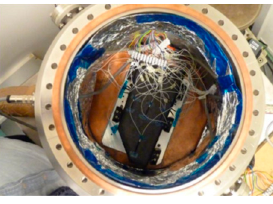
Figure 23. Breadboard inside the vacuum chamber fully integrated for thermal balance.